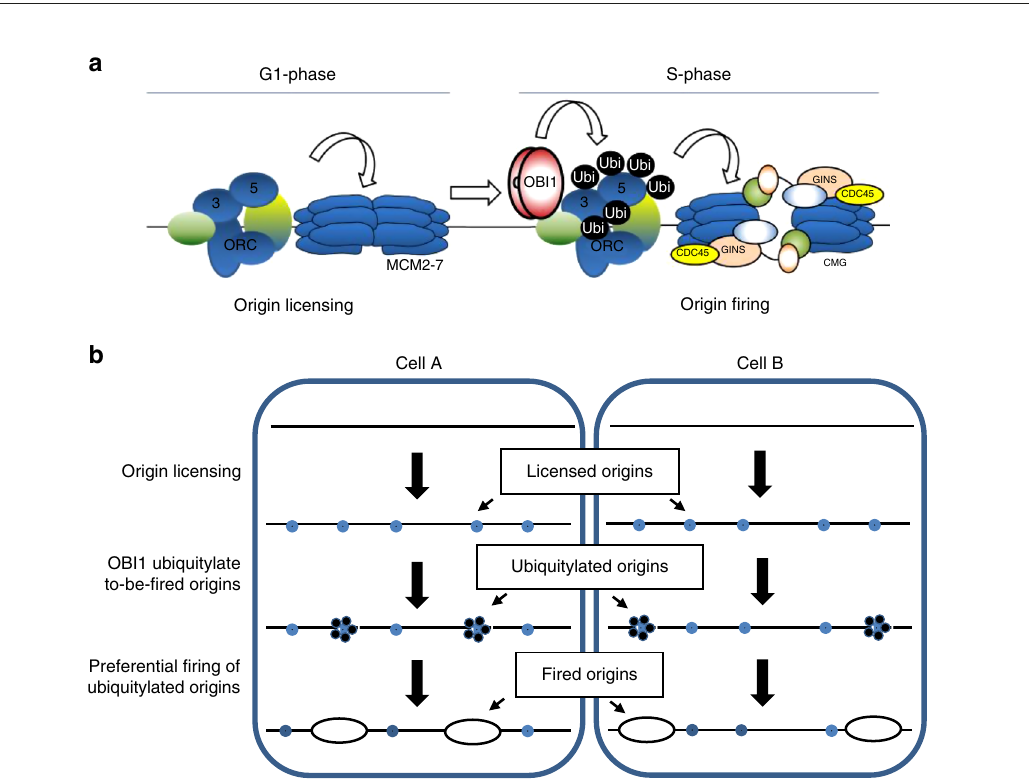
Fig. 5 ORC3 and ORC5 multi-mono-ubiquitylation is essential for origin fi ring. a U2OS cells were co-transfected with His 6 -tagged wild type (WT) ORC3 and ORC5 or lysine-less versions (0 K, see Supplementary Fig. 10a) and HA-ubiquitin, as indicated. Two days post-transfection, cells were lysed in denaturing conditions for His 6 -tagged protein puri fi cation. Expression and ubiquitin conjugation of the isolated proteins were monitored by western blotting. b U2OS cells were co-transfected with Myc-tagged (WT or 0 K) ORC3 and ORC5 or EGFP and Flag-ORC2. Two days after transfection, cell lysates were Flag-immunoprecipitated to purify the ORC subunit, and the association of co-expressed proteins was analysed by western blotting. Expression of Myc-tagged proteins in input extracts was also monitored. c U2OS cells were transfected with ORC3 and ORC5 (WT or 0 K), Myc-geminin or empty vector and with a puromycin-resistance plasmid. The next day, transfected cells were selected in puromycin medium for 2 days, and grown for another day without selection. Cells were then pulsed with BrdU for 15 min and analysed by fl ow cytometry (upper panels). BrdU incorporation fl uorescence signal was quanti fi ed from three independent experiments (lower left panel). Expression of ectopic proteins and endogenous PCNA was assessed by western blotting (lower right panels). ns, non-signi fi cant; * p < 0.01. d U2OS cells were treated as in c . Chromatin and soluble fractions were isolated and analysed by western blotting with antibodies against the indicated proteins. e DNA fi bre stretching analysis. U2OS cells were treated as in c . Cells were incubated with IdU (15 min; red) followed by CldU (15 min; green) and processed for DNA spreading. Representative images are shown. Scale bars, 5 μ m. The length of CldU tracks after the IdU signal was measured. More than 200 measurements are shown from two independent experiments. Red bars indicate median values. ns, non-signi fi cant; * p < 0.01